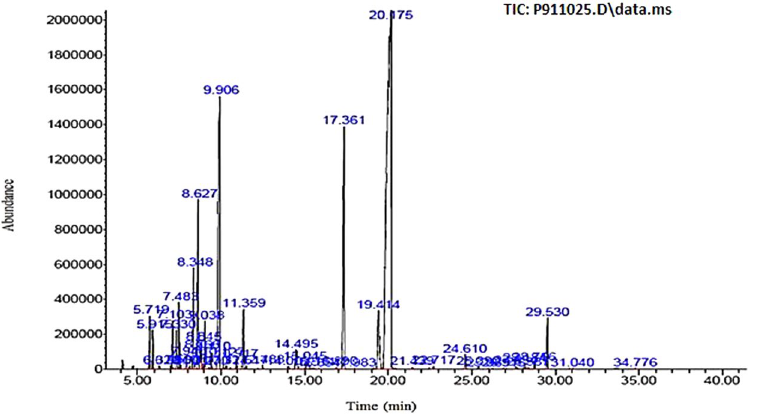
Figure 1. Gas chromatography-flame ionization detector (GC-FID) chromatogram of Zataria Multiflora essential oil. Elution time of peaks, component name and component percentage reported underneath. 5.719, α -Thujene (1.011%). 5.915, α -Pinene (0.765%). 6.320, Camphene (0.063%). 6.996, Sabinene (0.063%). 7.103, 1-Octen-3-ol (1.15%). 7.33, 3-Octanone(0.903%). 7.483, Myrcene (1.41%). 7.593, 3-Octanol (0.084%). 7.940, α -Phellandrene (0.27%). 8.131, δ -3-Carene (0.067%). 8.348, α -Terpinene (2.391%). 8.627, p -Cymene (4.299%). 8.766, Limonene (0.535%). 8.845, 1,8-Cineole (0.603%). 9.038, (Z)- β -Ocimene (1.085%). 9.270, Benzene acetaldehyde (0.051%). 9.41, (E)- β -Ocimene (0.414%). 9.906, γ -Terpinene (12.447%). 10.127, cis-Sabinene hydrate (0.24%). 10.324, trans-Linalool oxide (0.086%). 10.917, Terpinolene (0.268%). 11.359, Linalool (1.658%). 11.517, Hotrienol (0.084%). 12.488, allo-Ocimene (0.094%). 14.009, Borneol (0.098%).